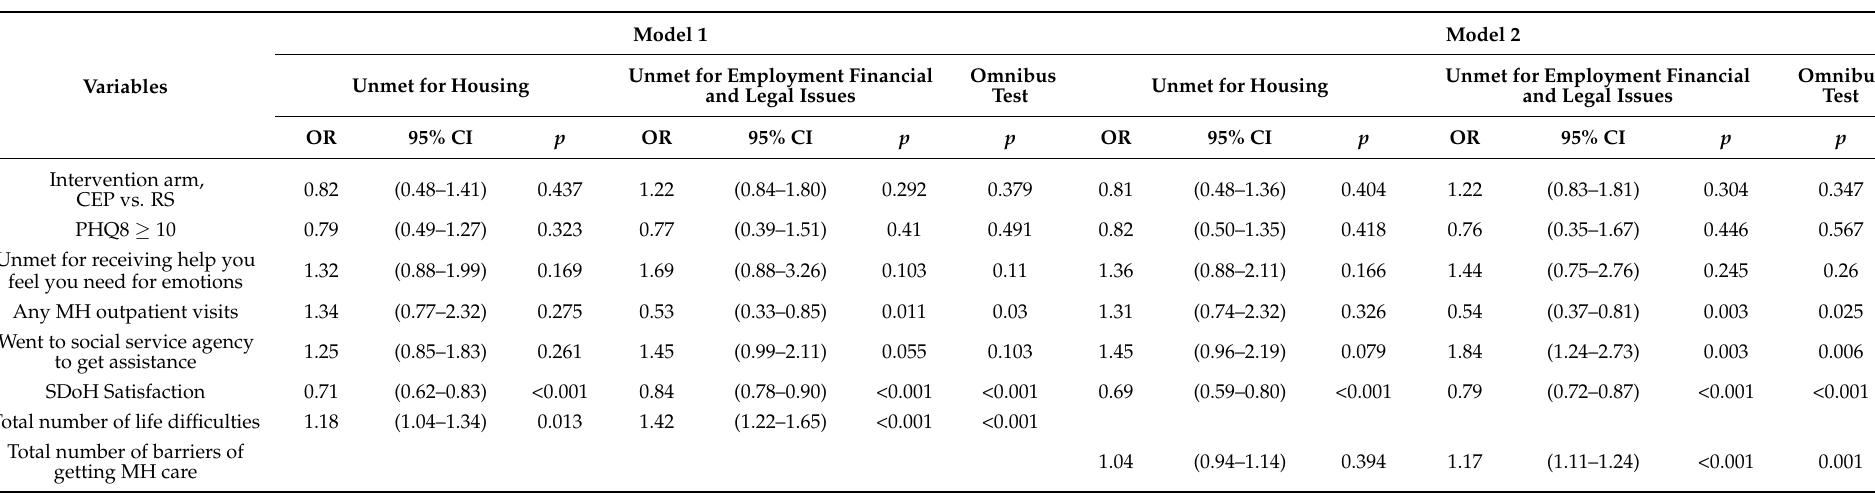
Table 3. Models for perceived unmet needs for housing assistance and employment financial and legal assistance at 36 months, by perceived life difficulties, life satisfaction, barriers to care, and service utilization controlling for intervention condition.